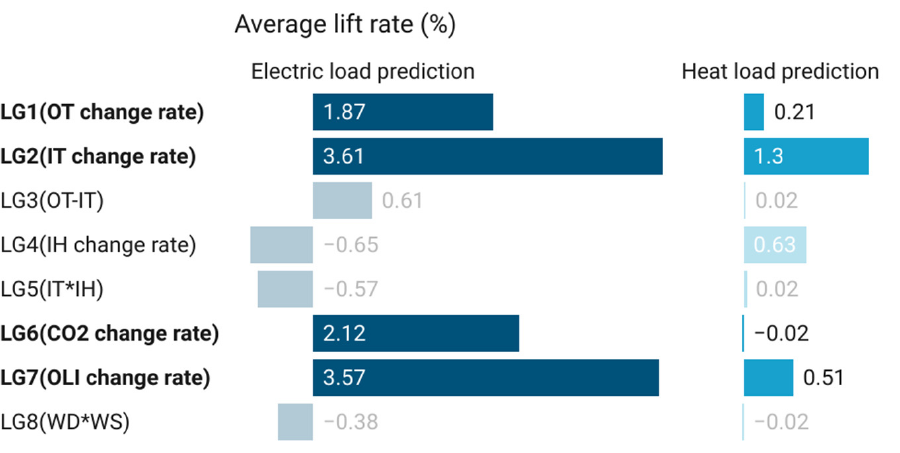
2 of the model (logic features).